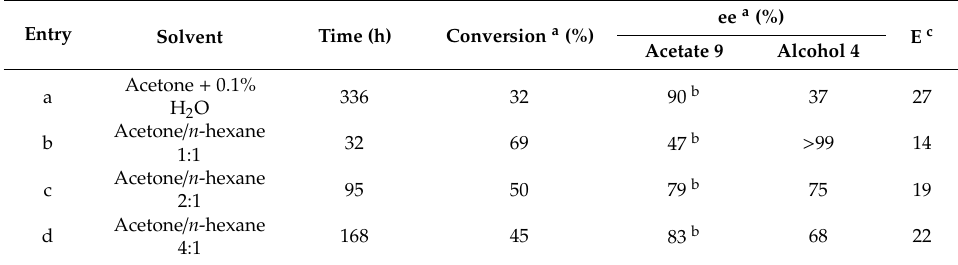
Table 4. CAL-A-catalyzed irreversible transesterification of rac - 4 in acetone with the addition of water or n